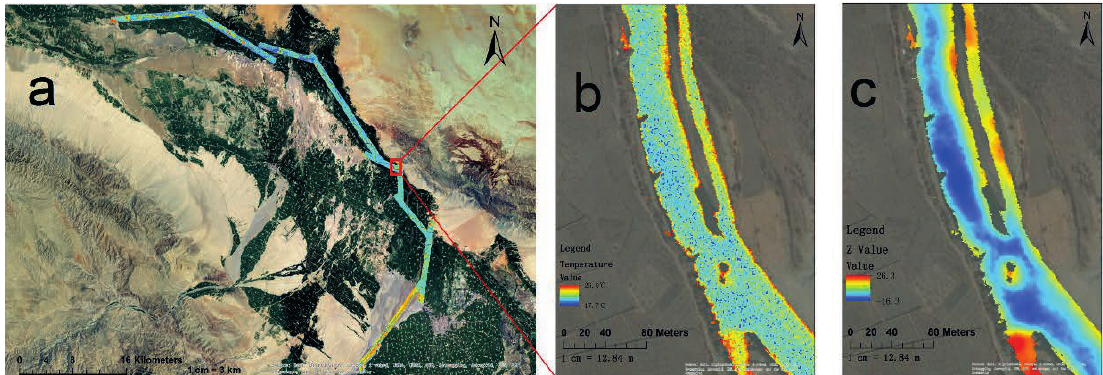
Fig. 2 (a) The surface temperature of the 90-km long river channel measured by airborne temperature sensing; (b) a selected segment of the river surface imagery which indicates the spatial locations of the groundwater discharge by visual interpretation, and (c) the abnormal temperature clustering patterns which indicate the groundwater discharge